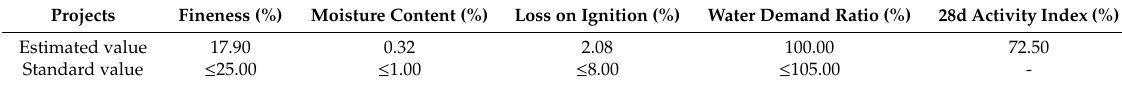
Table 2. Physical indexes of fly